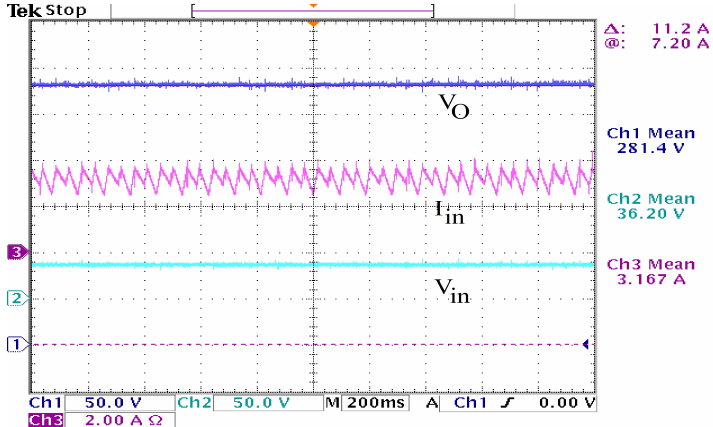
Figure 12. Input voltage, input current and output voltage.